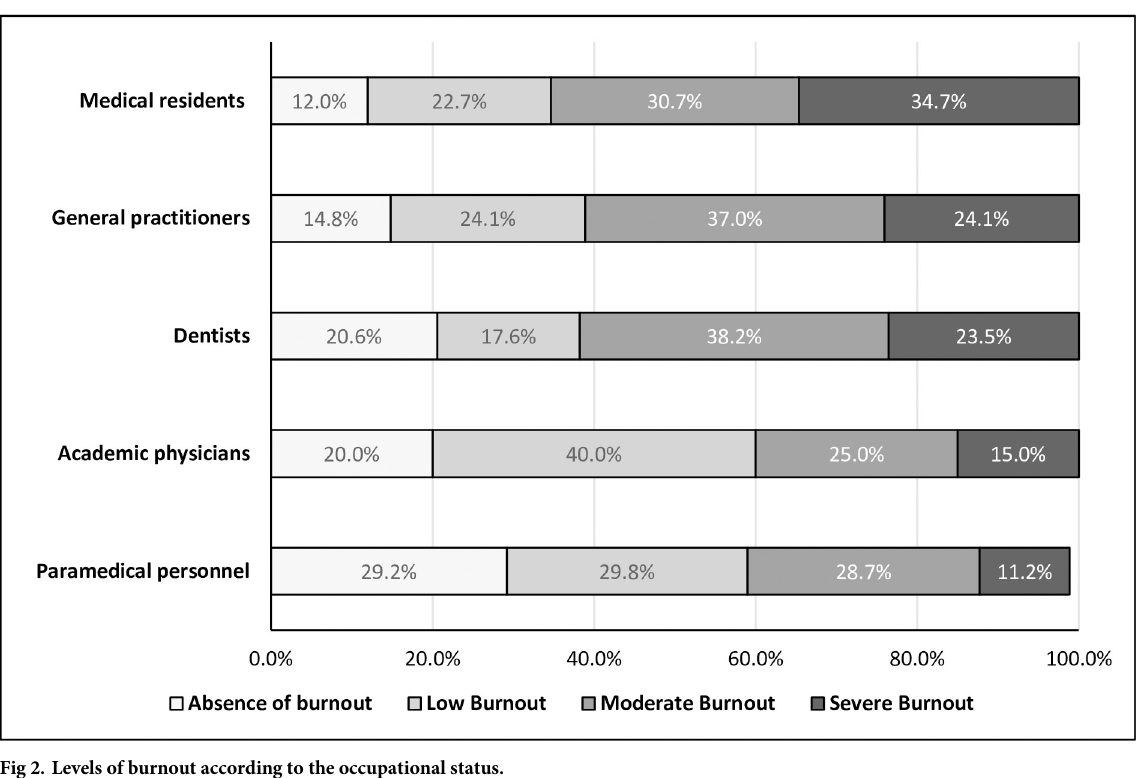
Fig 2. Levels of burnout according to the occupational status.